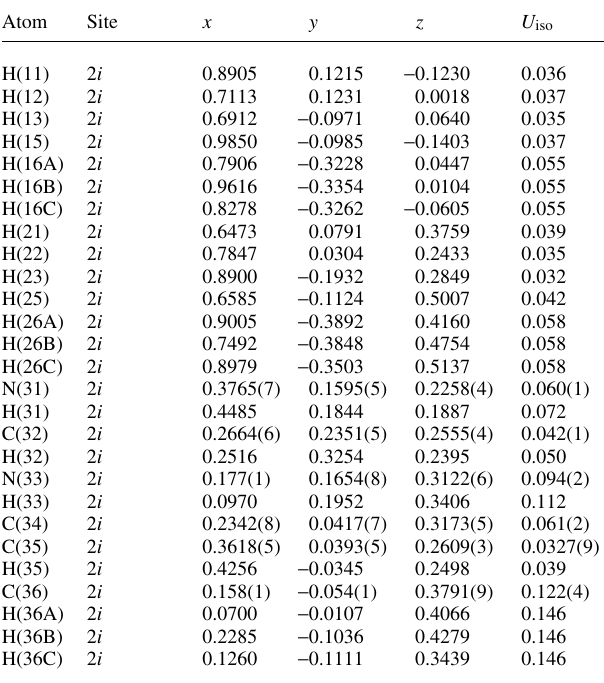
Table 2. Atomic coordinates and displacement parameters (in Å 2 ) .